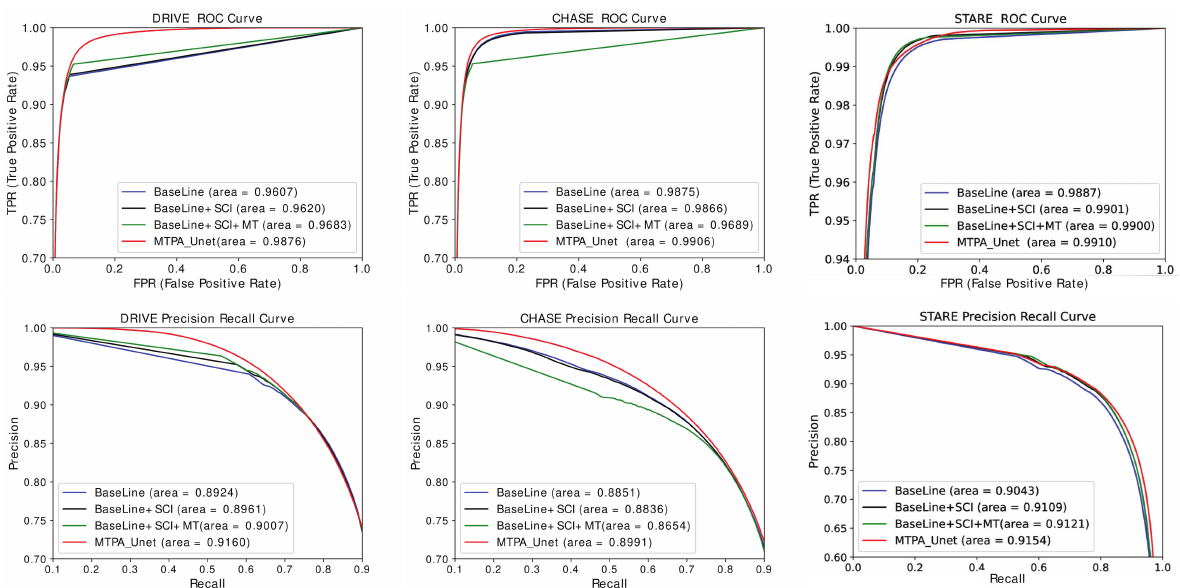
Figure 12. PR and ROC curves for each ablation